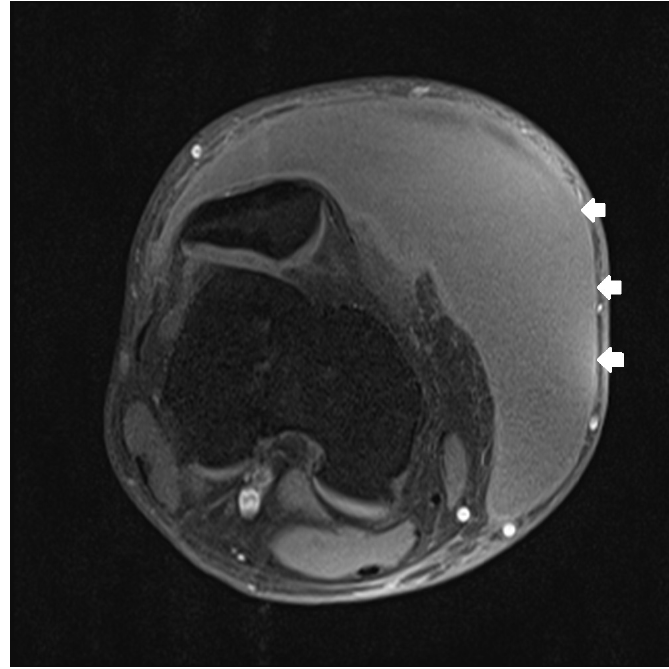
Figure 2c. Axial T-1 weighted magnetic resonance imaging with fat saturation shows a capsule of variable thickness (white arrows).